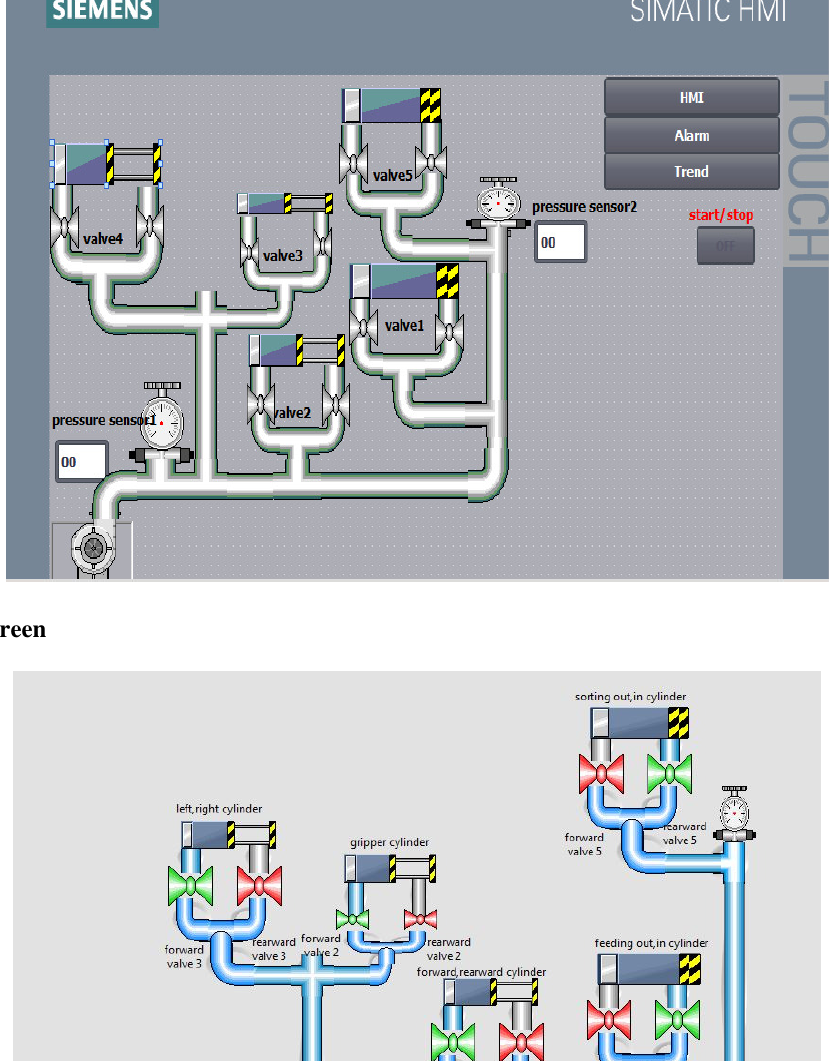
clamping cylinder reset). Finally, the robotic arm moved to rearward (the rearward cylinder set and forward cylinder reset) and the conveyer at sorting unit started as shown in figure